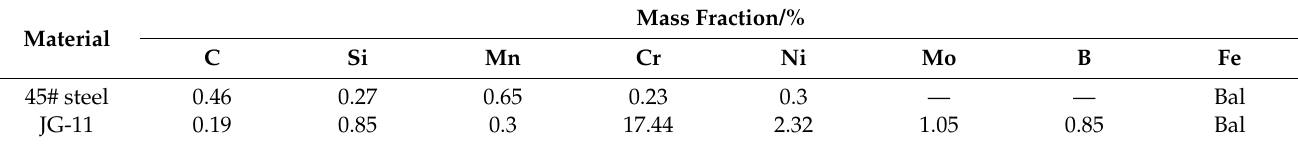
Figure 2. Microscopic morphology of JG-11 powder. Table 1. Key chemical composition of 45# steel and JG-11 powder.